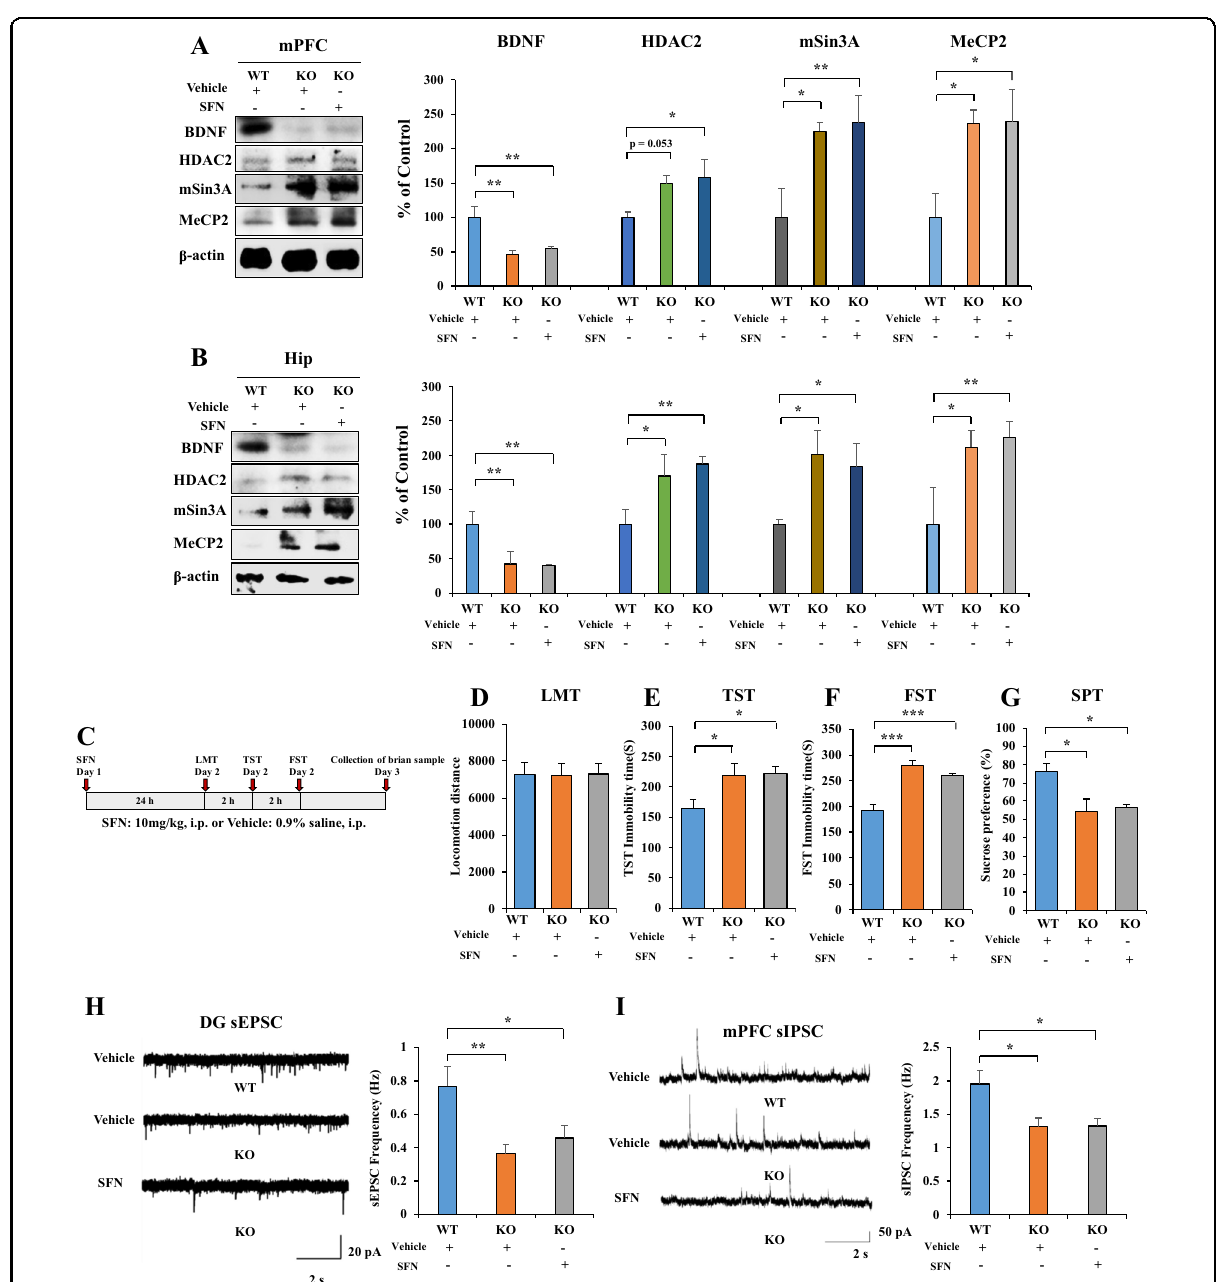
Fig. 4 Nrf2 KO mice show depression-like behavior, alter BDNF, HDAC2, mSin3a, and MeCP2 expression and frequency of sEPSC and sIPSC in hippocampus and mPFC neurons. A , B The western blot analysis for mPFC and hippocampus. The western blot was performed for Nrf2, BDNF, HDAC2, mSin3A, and MeCP2 in mPFC and hippocampus (mean ± SEM, n = 4 per group, one-way ANOVA, * p < 0.05, ** p < 0.01). C The behavior test for Nrf2 KO mice after the SFN treatment. D LMT: locomotion test, E TST: tail-suspension test, F FST: forced swimming test, G SPT: sucrose preference test (mean± SEM, n = 8 per group, one-way ANOVA, * p < 0.05, ** p < 0.01). H Left: representative traces of sEPSC in hippocampal DG neurons. Scale bars represent 2 s, 20 pA. Right: histograms of sEPSC frequency in hippocampal DG neurons (mean± SEM, n = 10 – 11 neurons of three mice per group, one-way ANOVA, * p < 0.05, ** p < 0.01). I Left: representative traces of sIPSC in mPFC neurons. Scale bars represent 2 s, 50 pA. Right: histograms of sIPSC frequency in mPFC neurons (mean ± SEM, n = 9 – 10 neurons of three mice per group, one-way ANOVA, * p <